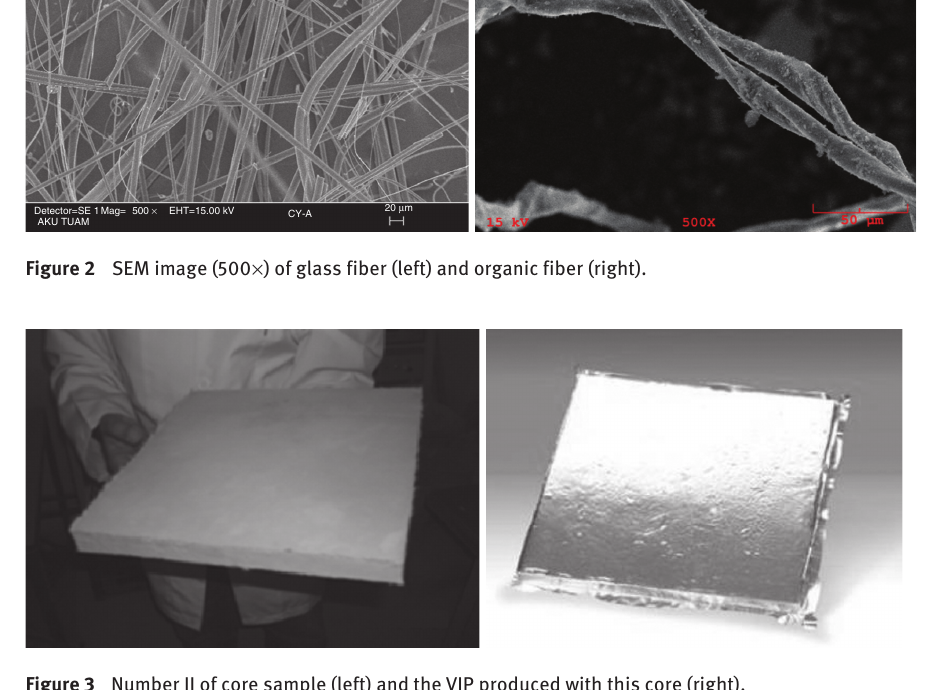
Figure 3 Number II of core sample (left) and the VIP produced with this core (right).